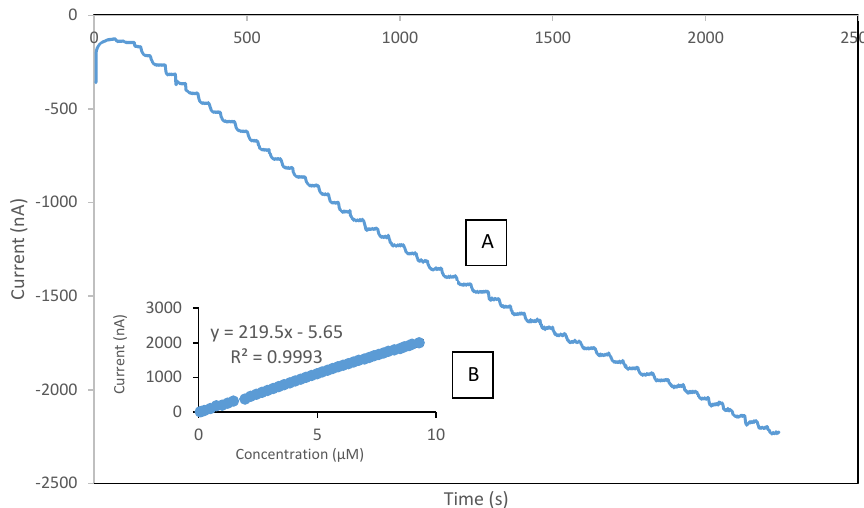
Figure 9. Typical current-time response curve ( A ); and calibration curves of phenol ( B ) obtained with SPCE/CTAB/PEG-ZrO 2 /Tyr on screen printed carbon electrode with the phenol concentration range of 0.075–10 µM.